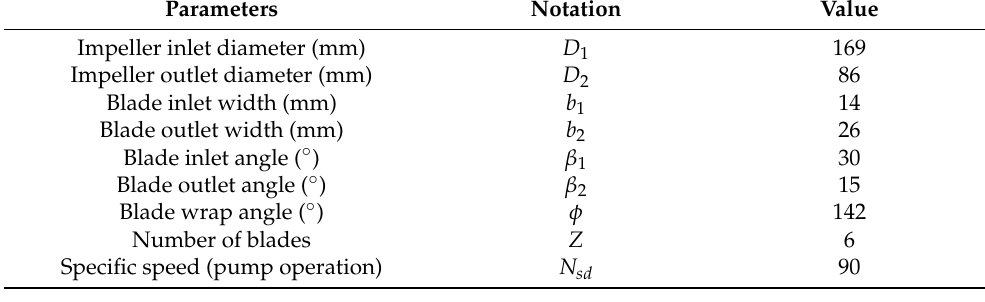
Figure 5. Schematic of the current experimental system ( a ), and a picture of this system in the lab ( b ).